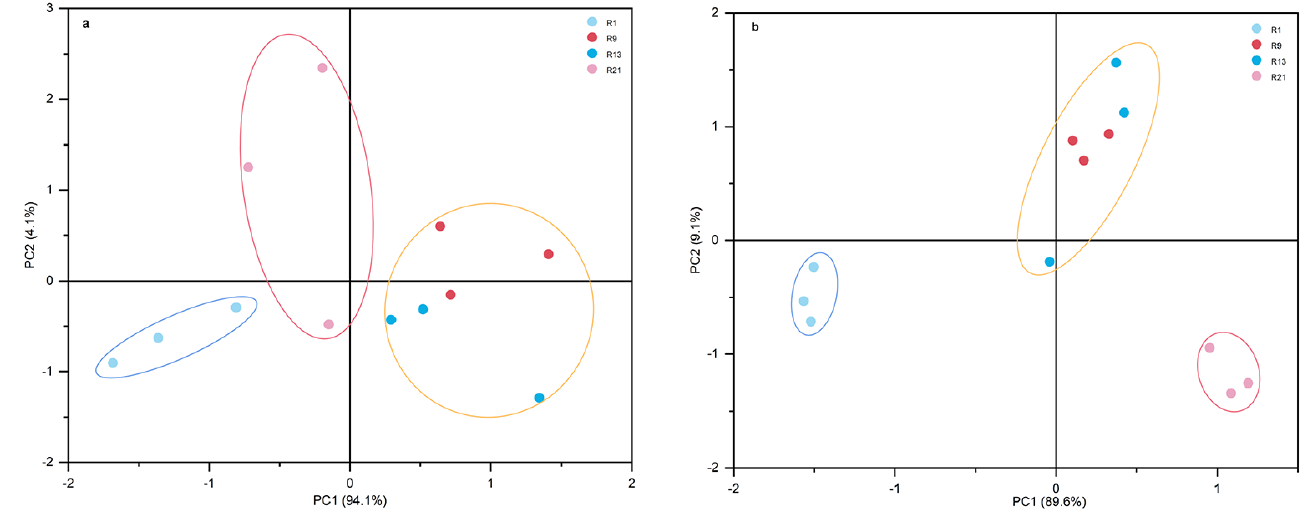
Figure 6. The principal component analysis (PCA) of the microbial community composition in soils ( a ) and P fraction ( b ) under long-term continuous cropping.